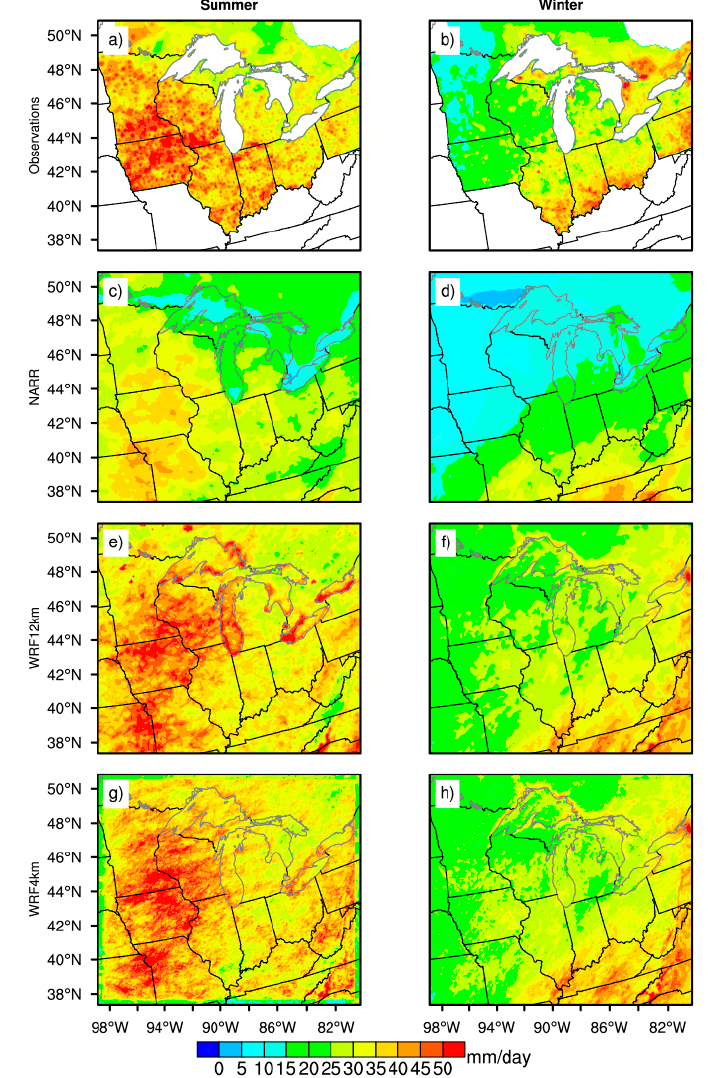
Figure 8. Same as Figure 7, but for 99 th percentile extreme daily precipitation (PCP).